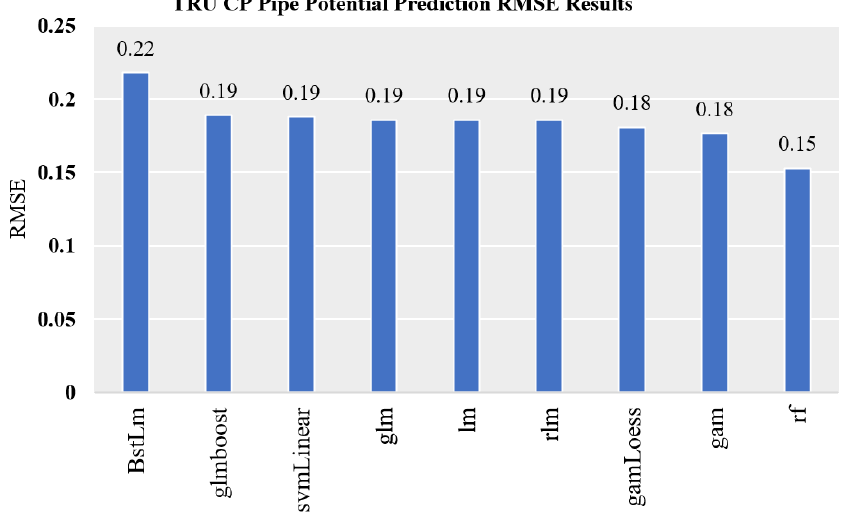
Figure 13. TRU CP pipe potential prediction results